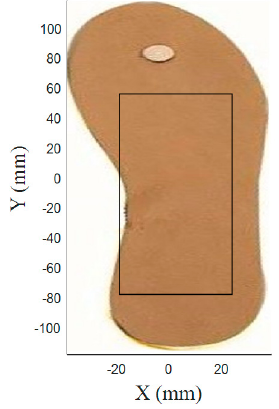
Figure 14. Representation of the area of the insole occupied by the COP.